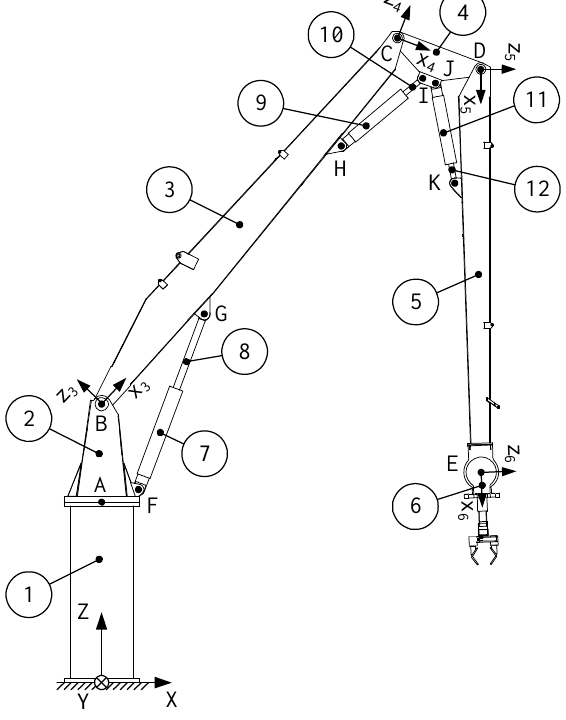
Figure 4: Topology of mechanical system